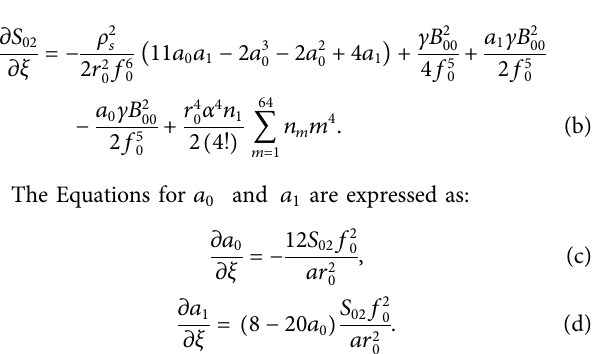
FIGURE4| Powerspectrumofnormalizedmagnetic fi eld fl uctuations | B k | 2 (cid:9) IC-3 at t = 15. “ Reproduced from [Gaur et al. (2014), Astrophys Space Sci (2014) 350 , https://doi.org/10.1007/s10509-013-17701], with the permission of Springer Publishing.